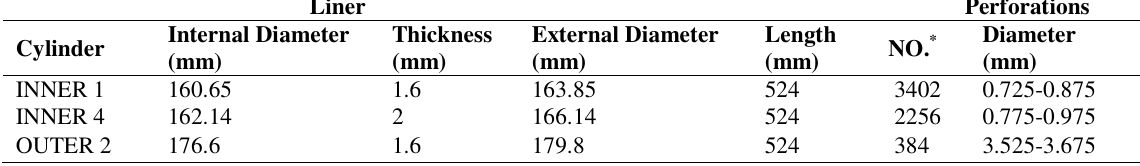
Fig. 3. demonstrates the sound powers through the perforated liners. The (P (Pi) represents the transmitted, absorbed, reflected, and incident sound powers, respectively. Table 1, Illustrates the characteristics of the double-layers and single-layer perforated liner.